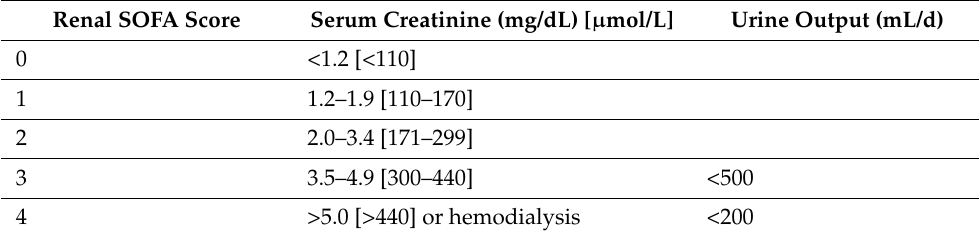
Table 2. The renal SOFA score